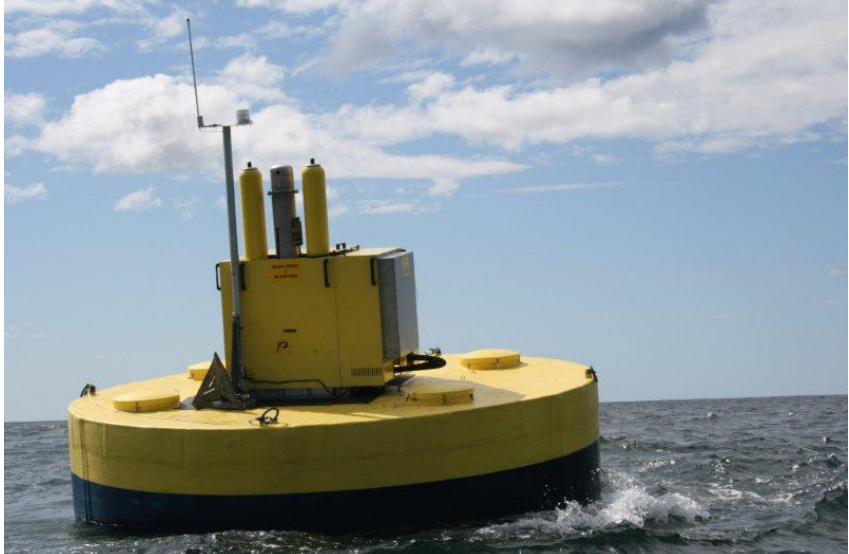
Figure 4. FO’s Wave Energy Converter Bolt R (cid:13) , located outside Risør, Norway has been in operation since June